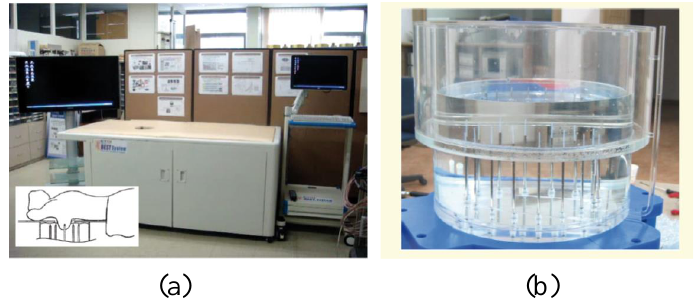
Figure 7. A prototype imaging system developed by Son et al. [68]. ( a ) View of the entire system. ( b ) View of the breast holder showing the antenna array in the liquid bath. Reprinted with permission from [68].